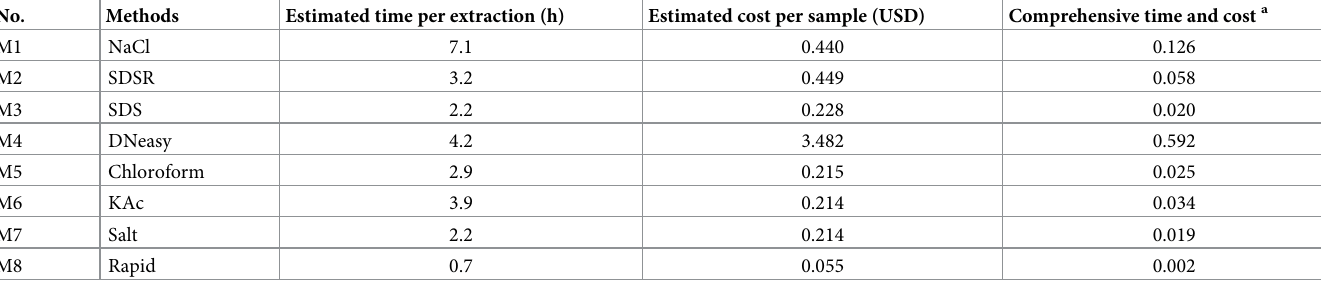
Table 3. Estimated cost and time required per extraction by using eight commonly used